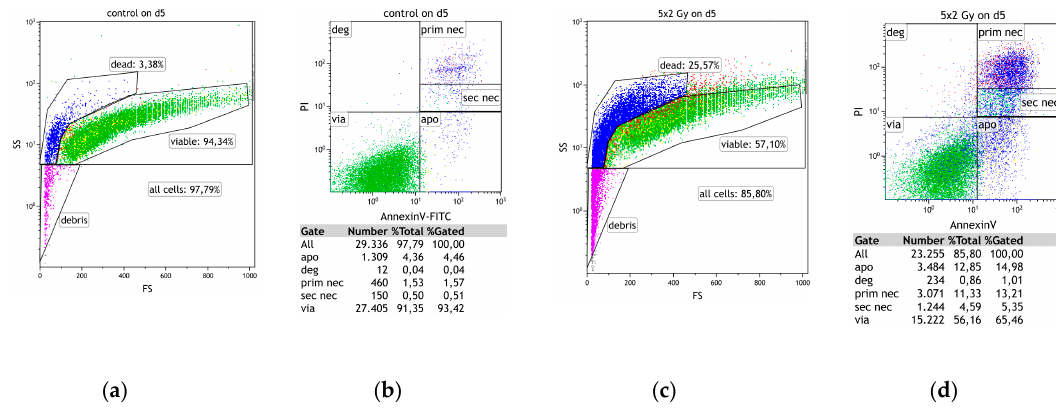
Figure 18. Cell death forms detection by Annexin V / PI staining and analysis by flow cytometry. Morphological changes and AnnexinV / PI staining of MDA-MB-231 tumor cells without ( a , b ) and with irradiation at 5 × 2 Gy ( c , d ) at day 5 after treatment is displayed exemplarily. Flow cytometry was used to distinguish viable and dead cells ( a , c ) by their FSc / SSc morphology as well as by their AnnexinV / PI binding properties ( b , d ); via: viable; apo: apoptotic; prim. nec: primary necrosis; sec. nec: